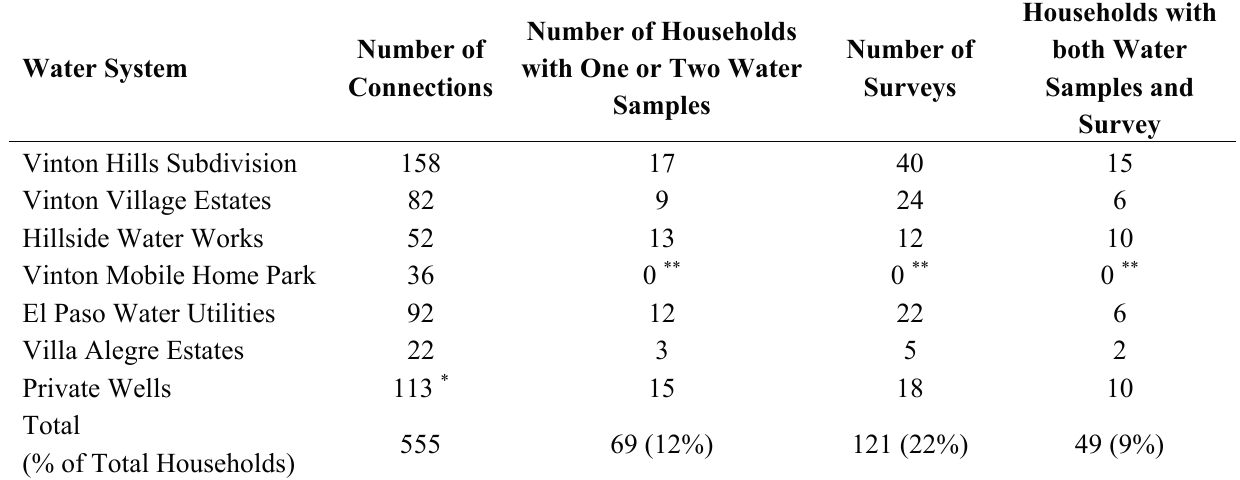
Table 1. Water sources, number of connections, and number of